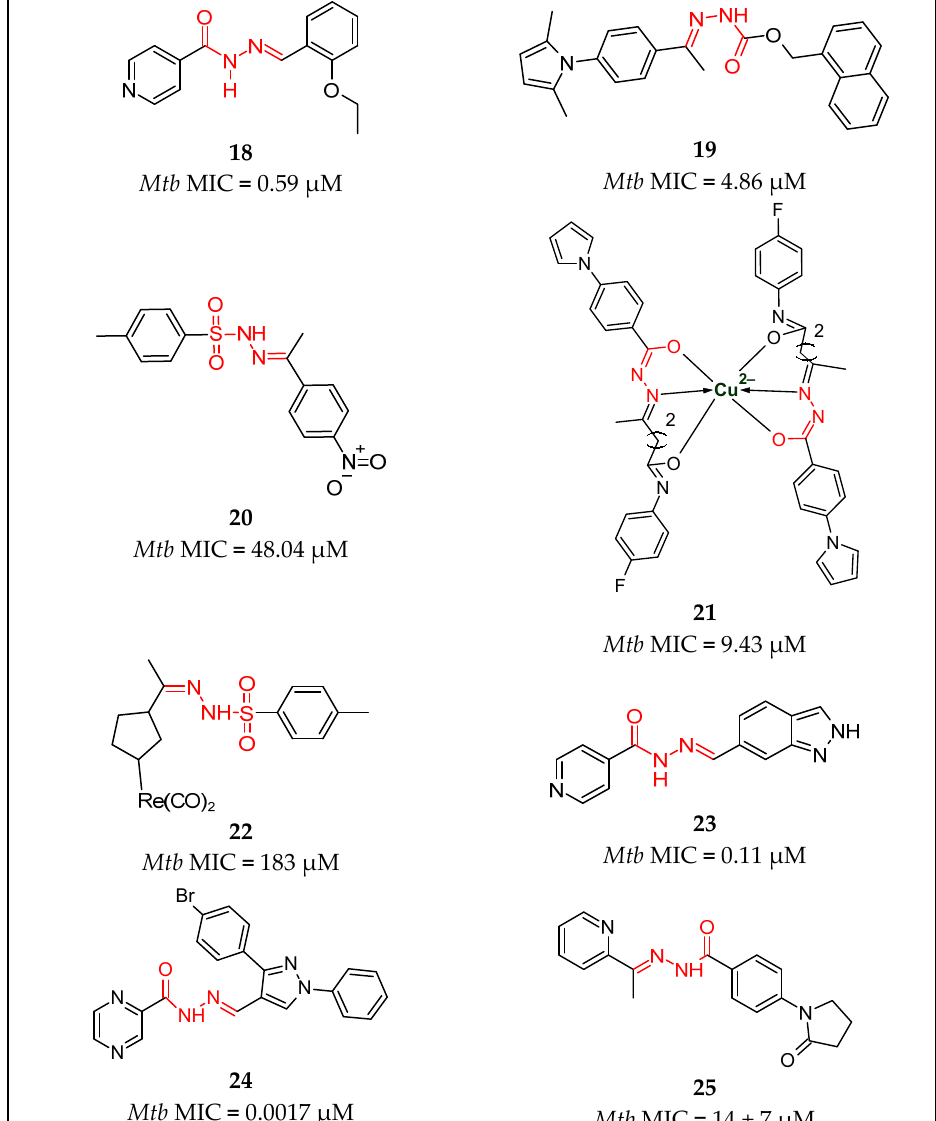
Figure 7. Chemical structures of compounds 18 [42] , 19 [43] , 20 [44] , 21 [45] , 22 [46] , 23 [47] , 24 [48] and 25 [49] .